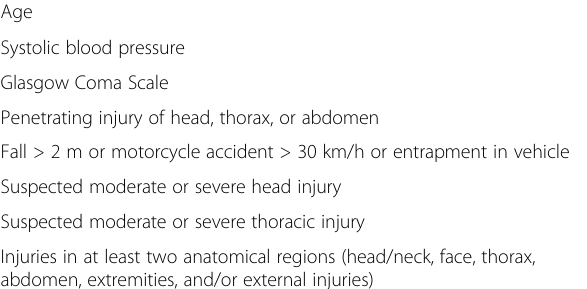
Table 2 Variables of the prediction model incorporated in the Trauma Triage